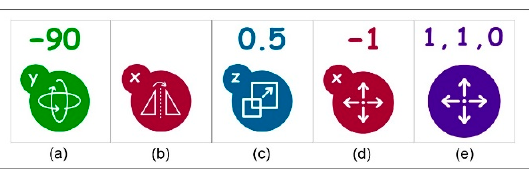
Figure 14. Examples of card design. ( a ) Rotation of minus 90 degrees on Y-axis; ( b ) Reflection on X-axis; ( c ) Scale factor of 0.5 on Z-axis; ( d ) Translation of − 1 on X-axis; ( e ) Translation of one unit on X-axis and one unit on Y-axis.